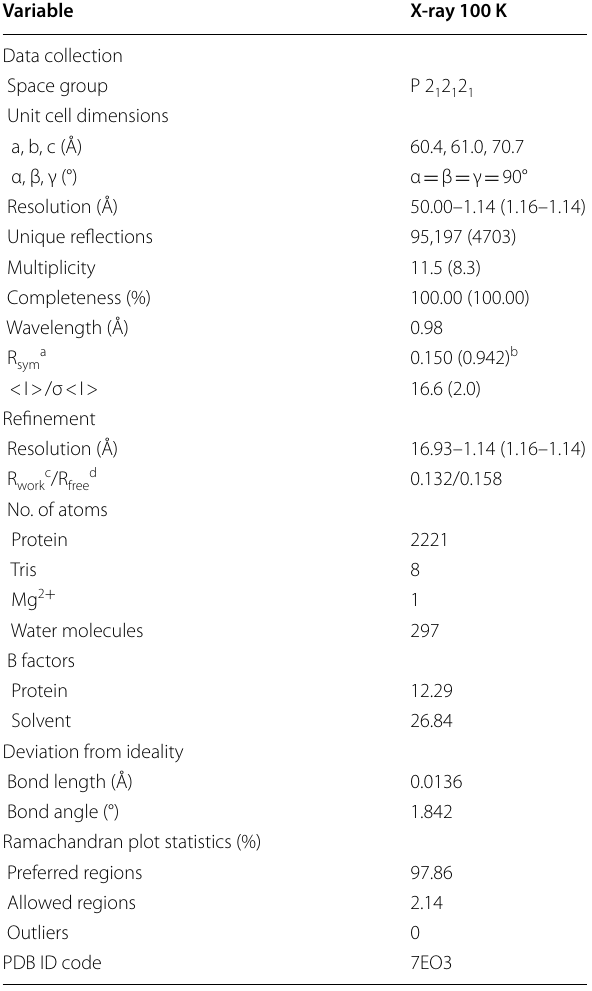
Table 2 Diffraction data collection and refinement statistics